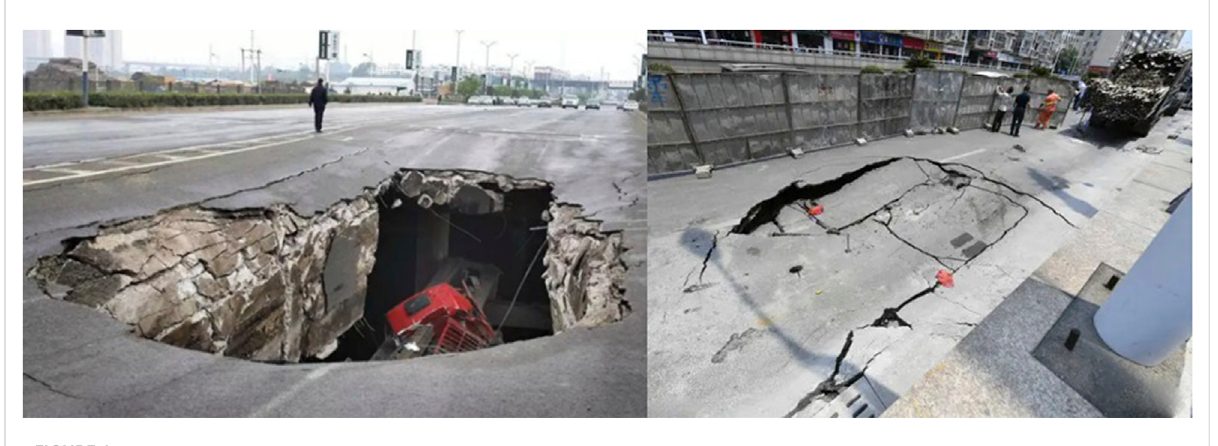
FIGURE 1 Ground subsidence caused by shield